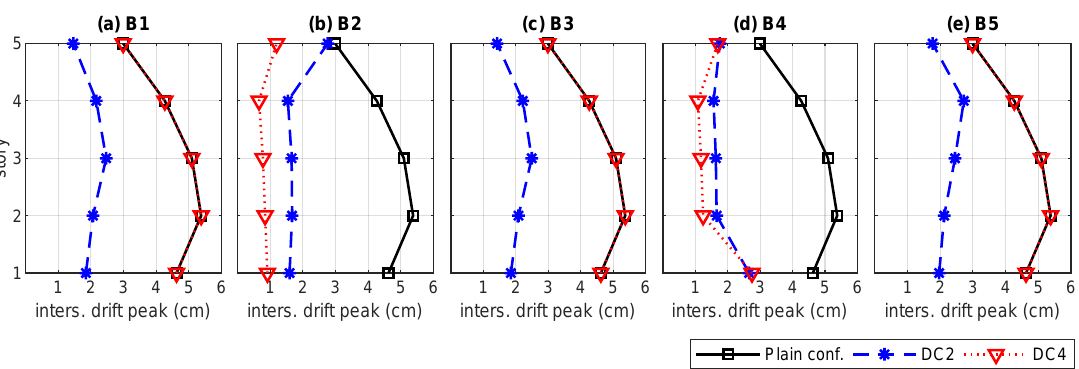
Figure 13. Maximum absolute interstory drifts corresponding to the nonactuated multibuilding system (plain configuration), the linked configuration DC2 and the unlinked configuration